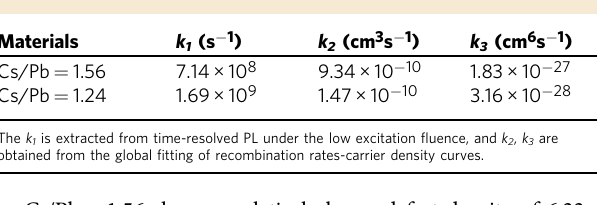
Table 1 The fi tted results of recombination rate constants for thermally evaporated perovskite fi lms with different Cs 4 PbBr 6